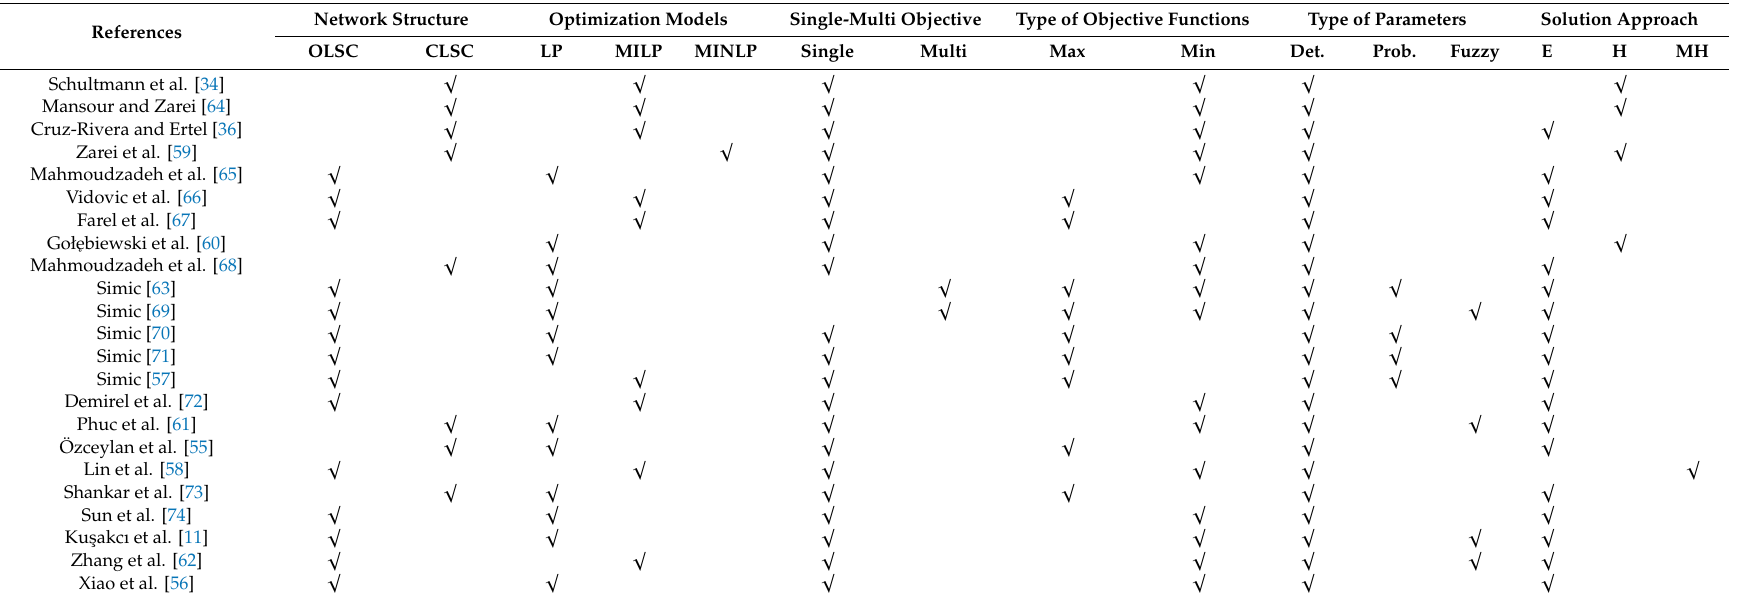
Table 6. Summary of the characteristics of the ELVs reverse logistics